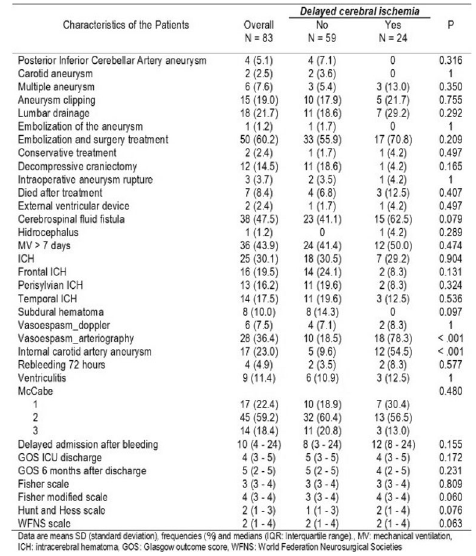
Table 1b (abstract 001113). Characteristics of the